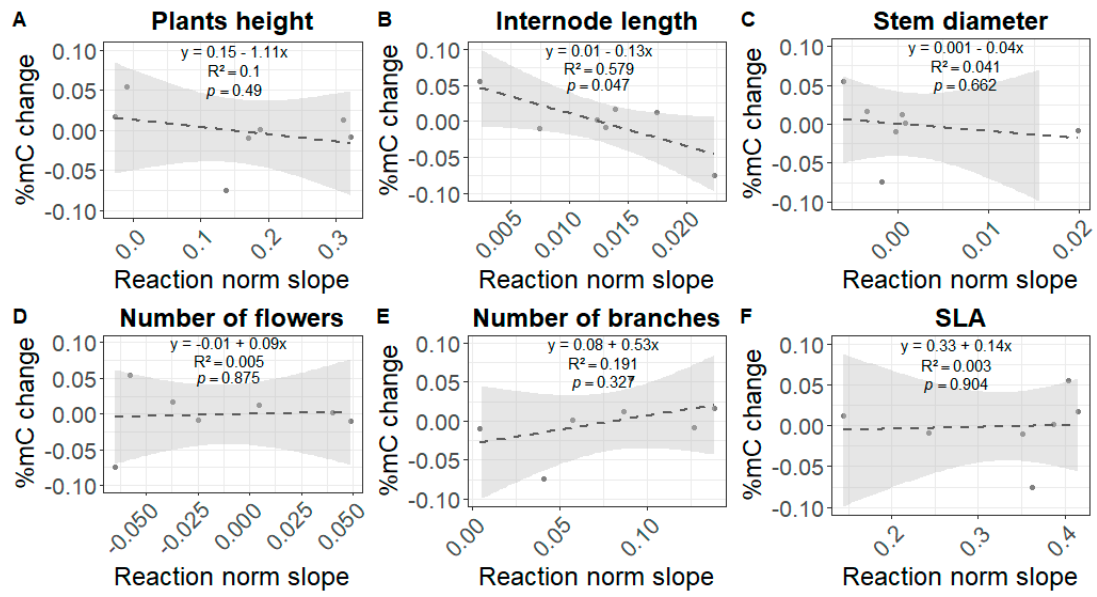
Figure 3. Relationship between the strength of shade avoidance responses and global DNA methylation changes. Changes in global DNA methylation percentages (%mC) as a function of the magnitude of the reaction norm to shade of plants. Both %mC change and reaction norm magnitude in response to shade are expressed in terms of slope coe ffi cients for height in cm ( A ), internode length in cm ( B ), stem diameter in mm ( C ), number of flowers ( D ), number of branches ( E ), and SLA in m 2 · kg − 1 ( F ). Equations, test probabilities, and coe ffi cients of determination ( R 2 ) are given for each trait. The gray area represents the 95% confidence interval around the dotted line, which represents the regression line. Each dot represents one highly inbred line. Statistical power of the chi 2 tests for the e ff ect of the %mC change on the slope of the reaction norm was estimated using power analyses defined by Cohen (pwr package in R): 13.3% for plant height, 99.8% for internodes length, 6.3% for stem diameter, 5% for the number of flowers, 35.9% for the number of branches, and 5% for the